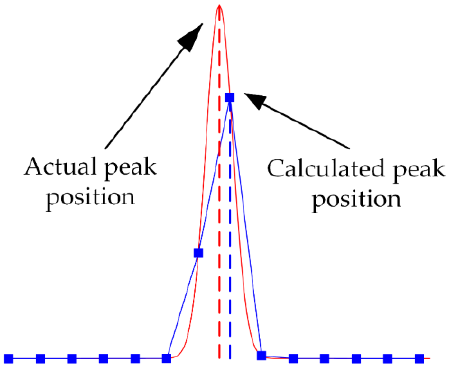
Figure 5. Error in peak identification of location spectrum.